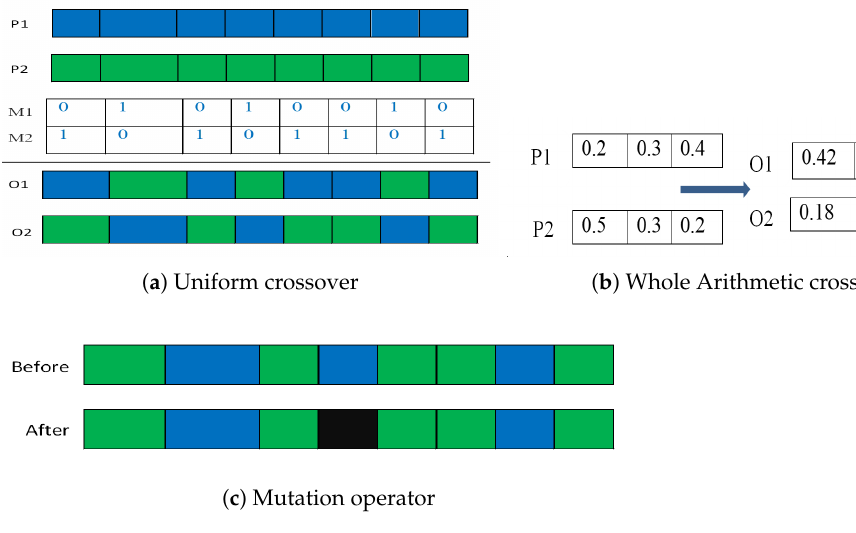
Figure 2. Different genetic